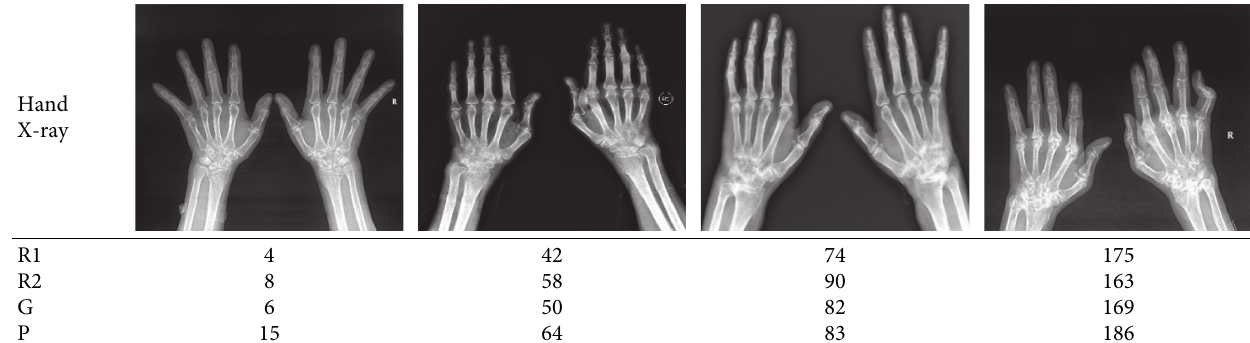
Table 6: Four sample cases of hand X-rays. The score of two radiologists (R1, R2) is shown on the 2nd and 3rd rows, respectively. The 4th row (G) is the average score of two radiologists. The 5th row (P) denotes the predicted score of the ResNet-Dwise50 model. Green: near average score. Red: more than 15 points from the average